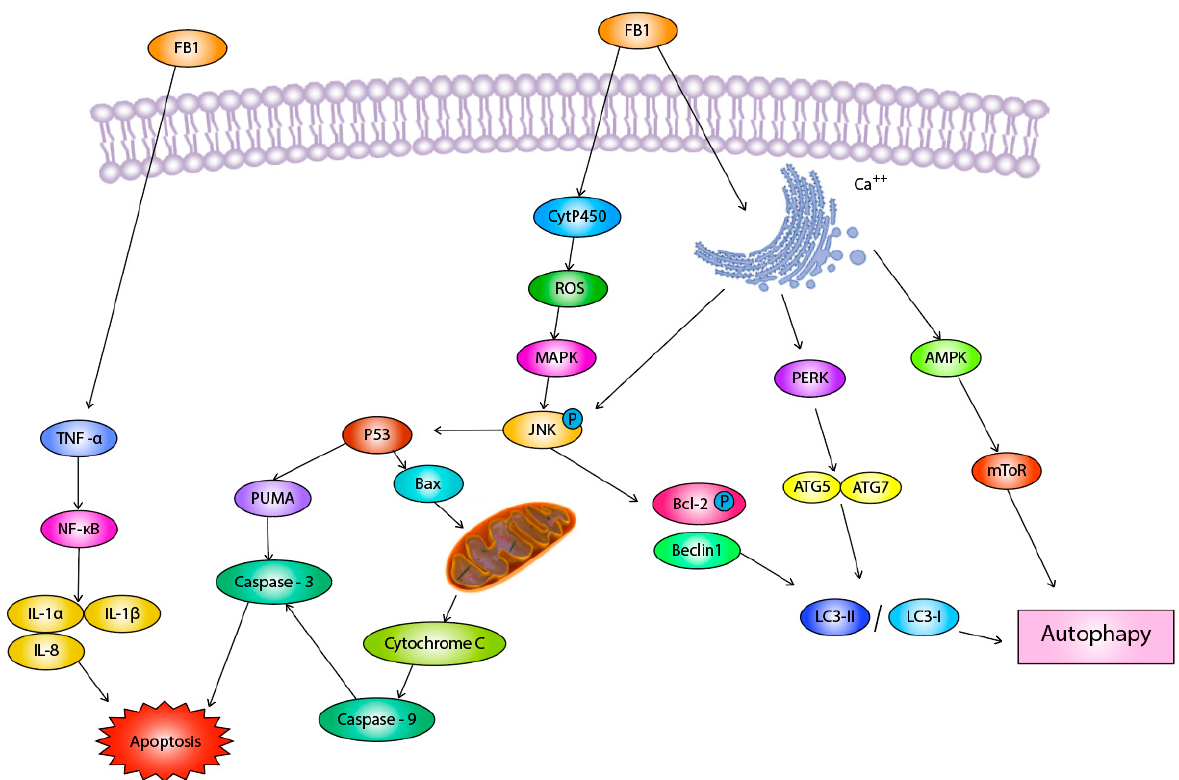
Figure 2. Mechanism of FB1 toxicity.